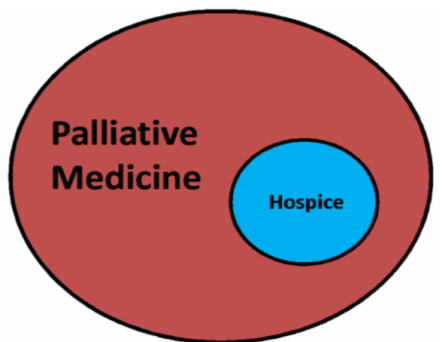
Figure 2. Palliative Medicine and Hospice Care. Adapted from Palliative Medicine and Geriatric Emergency Care